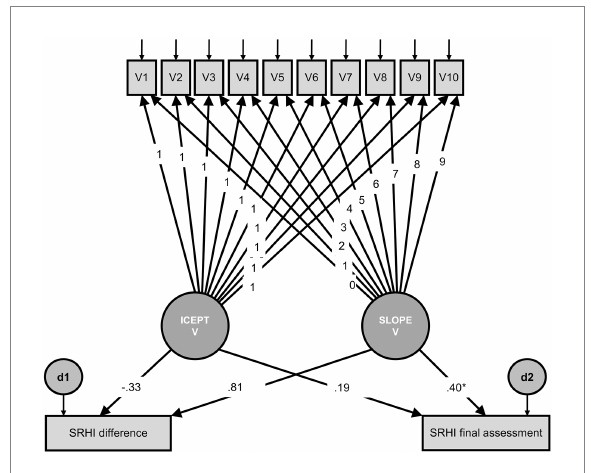
FIGURE 3 Model for valence as a predictor of final habit strength and change in habit strength. V1–V10 = observed valence, measured at 10 time points, with residuals; ICEPT V = latent intercept of valence, all paths to the observed valence variables were constrained to 1; SLOPE V = latent slope of valence, the paths to the observed valence variables indicate linear growth; d1 and d2 = residuals; SRHI difference = observed change in habit strength (final assessment minus initial assessment); SRHI final assessment = observed habit strength in the final assessment; * p < 0.05; ** p < 0.01; *** p < 0.001. Model fit: χ 2 = 74.79, df = 68, p = 0.268; CFI = 0.94; RMSEA = 0.03 (90% CI